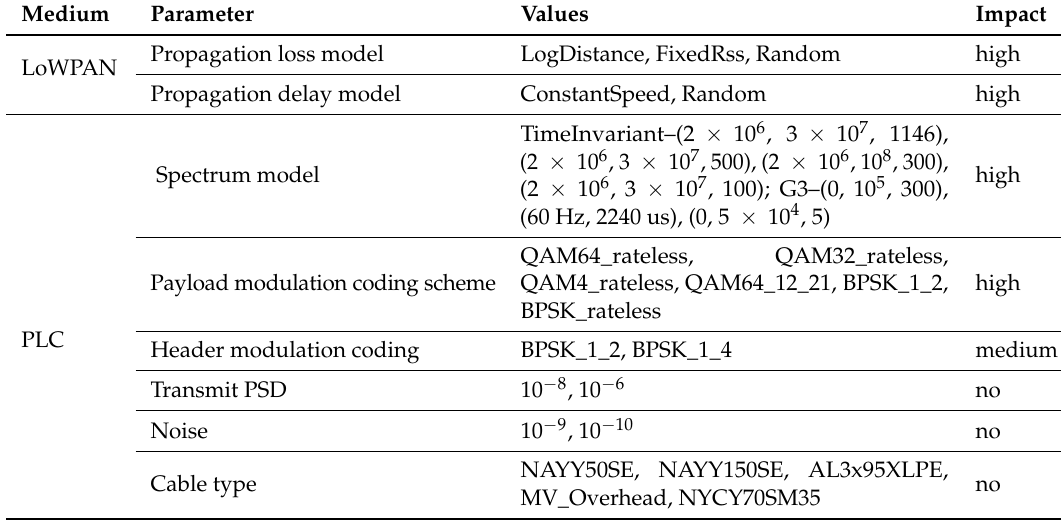
Table 2. Basic configuration and parameter verification of PV-Smart Meter